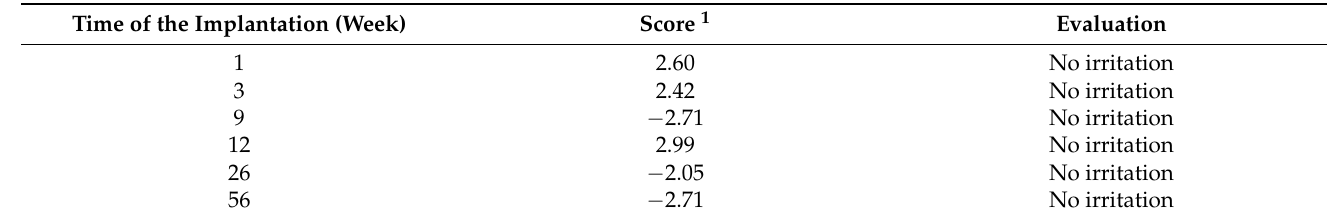
Table 4. The evaluation score for the general-response estimation of the tested